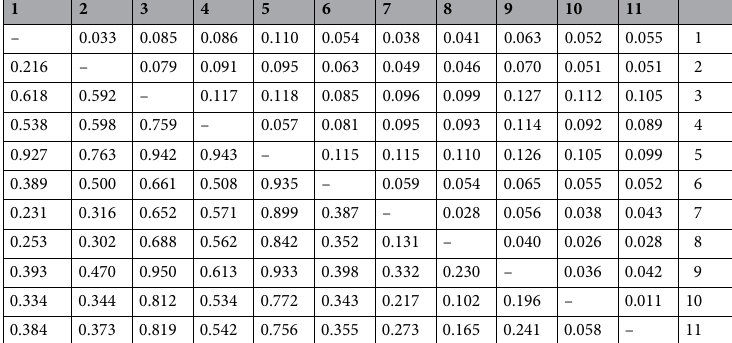
Table 5. Pair-wise population matrix of Nei’s genetic distance (below diagonal) and F ST values (above diagonal) among Indian sheep breeds. NT region: 1 = Rampur Bushair, 2 = Poonchi, 3 = Changthangi; ET Region: 4 = Bonpala, 5 = Tibetan, 6 = Shahbadi, 7 = Balangir; SP region: 8 = Kenguri, 9 = Bandur, 10 = Hassan, 11 =